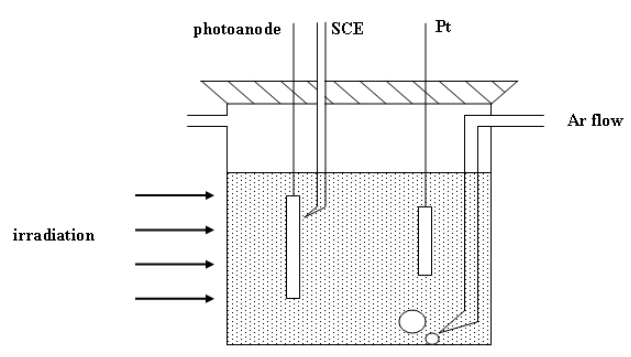
Figure 2. Structural drawing of a three-electrode photoelectrochemical cell.